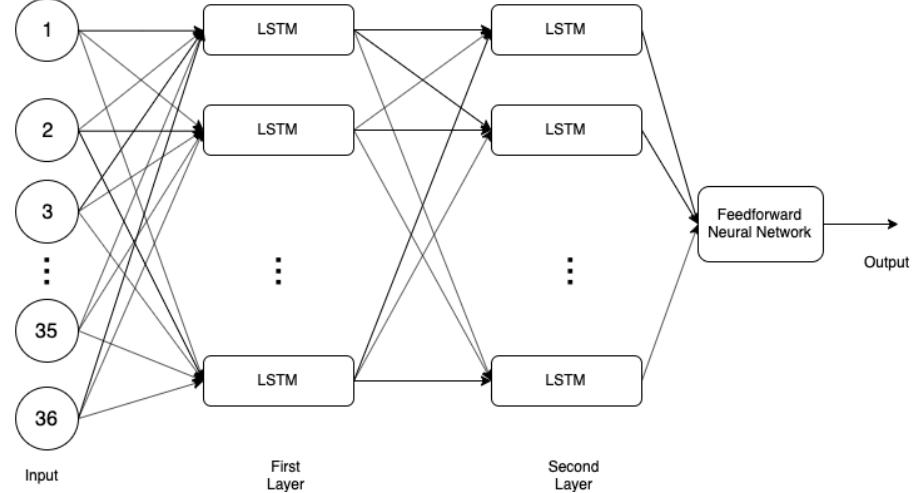
Figure 2. Deep learning architecture, depicting two LSTM layers with a dropout of 0.2, 100 and 50 neurons in the first and the second respectively and a feedforward network with 30 and 10 neurons in each layer, for 36 inputs (the 2D coordinates of the 18 nodes human body model) and the output (a 3 × 1 vector for the 3 possible classifications of human